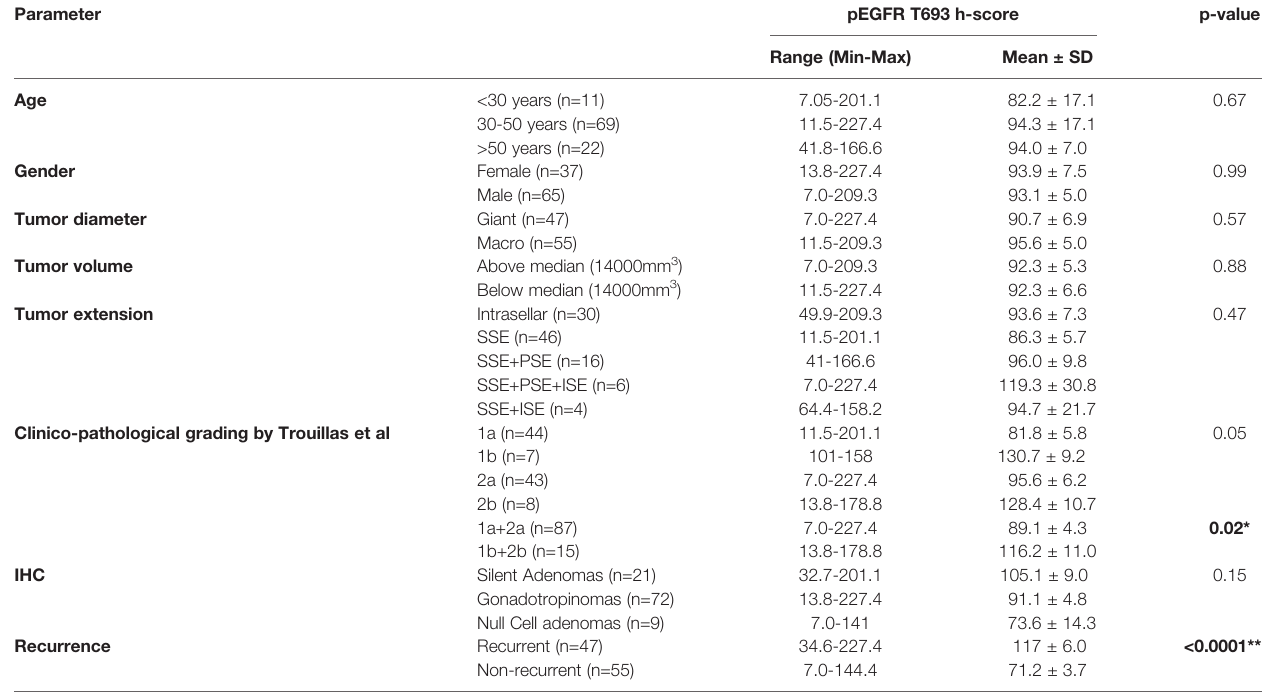
TABLE 1 | Baseline clinical, radiological and histopathological characteristics of the cohort with composite h-scores strati fi ed on the basis of demographic characteristics. Parameter pEGFR T693